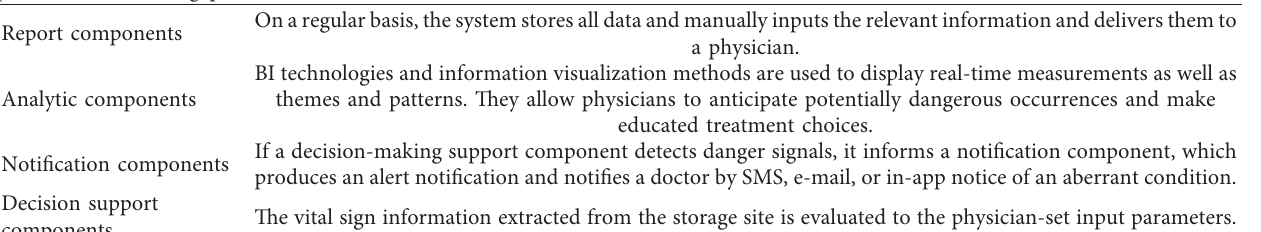
Table 1: How the RPM online solutions should be connected with a hospital’s EMR system through an FHIR-based API to share data and prevent information gaps?